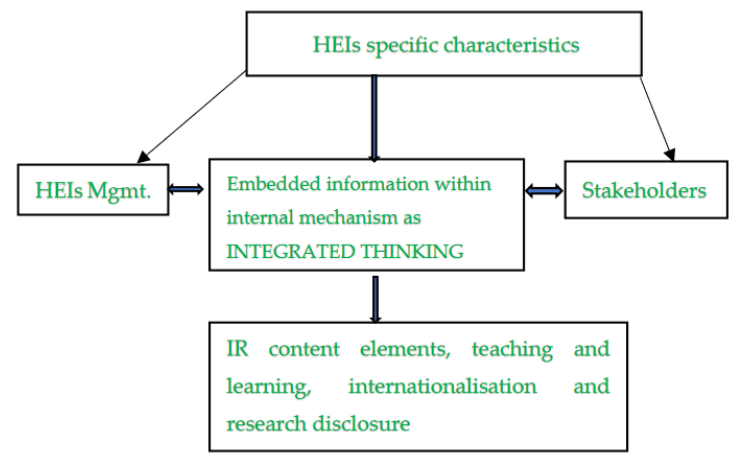
Figure 1. Integrated thinking and HEIs core activities disclosure.